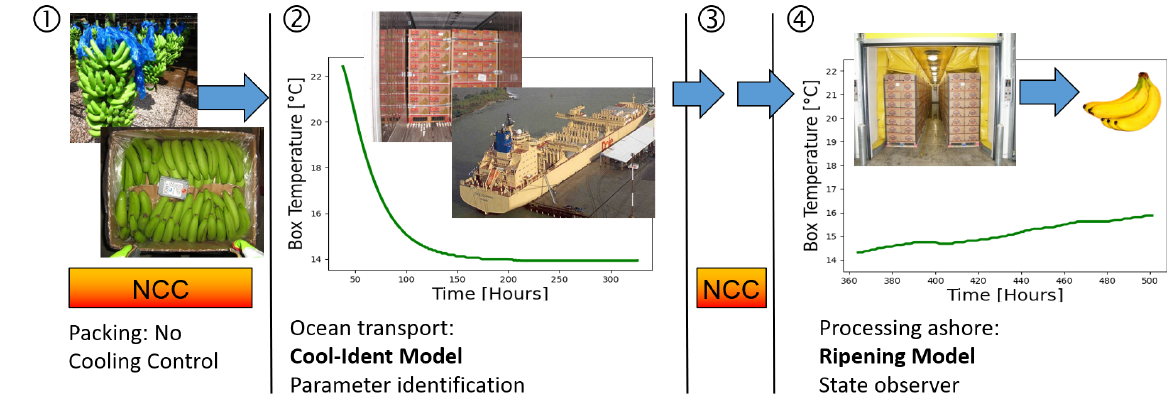
Figure 4. The banana cool chain, processing chain, and related models (NCC represents no cooling control). Own illustration. Photo of cooling vessel provided by Dole. Banana icon downloaded from https://www.freepngimg.com/ (last access: 3 November 2022).